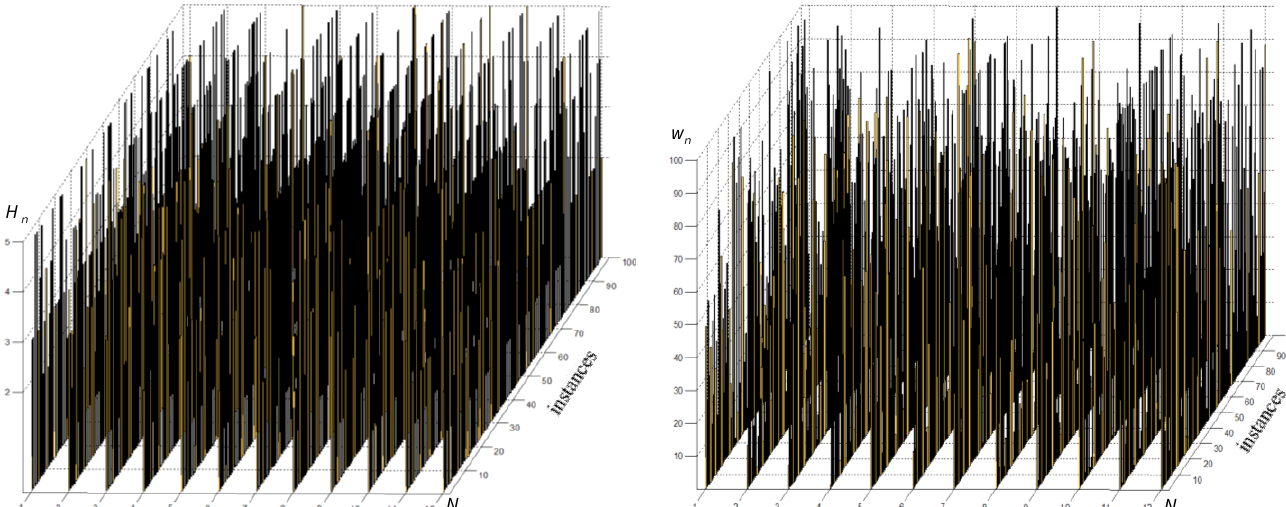
Fig. 10. Job lengths and weights generated for 100 instances of scheduling 12 jobs, where 58 instances are unique (even less than that in the case of scheduling 11 jobs). The 19 non-timeout instances are barred with a lighter colour. The 13 non-timeout instances are unique. Despite one job longer series of integers generated by (53) and (54) is returned concurrently on each of two CPU cores (first, a pair of vectors of job lengths is generated, and then a pair of vectors of priority weights is generated on the cores), the pseudorandomness here has been violated severer than that in generating 100 instances of 11 jobs. It is an